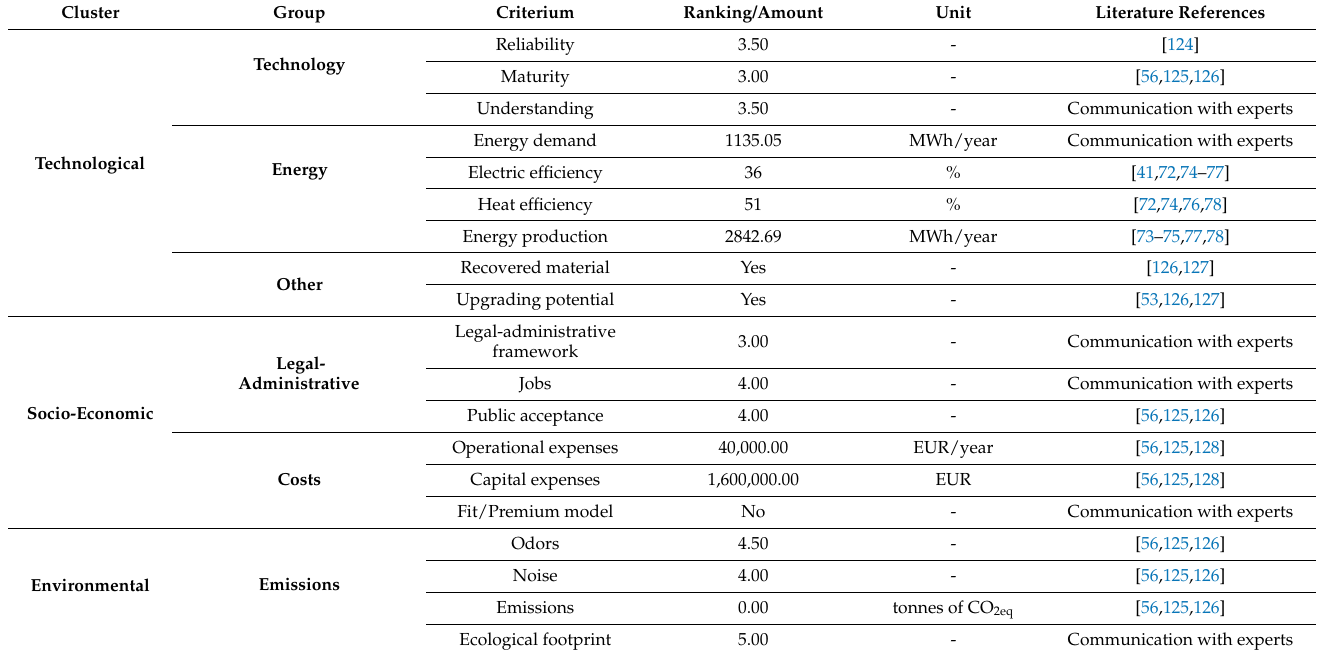
Table 7. Input data for the ranking of material recovery